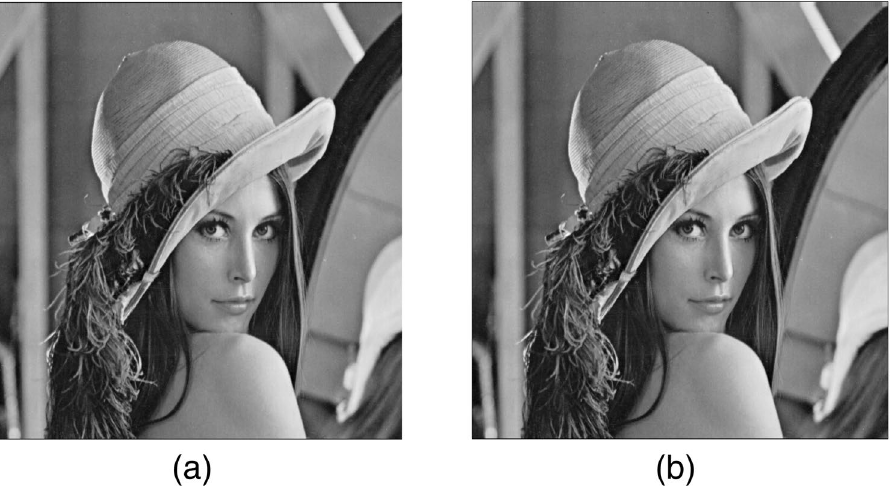
Figure 4. Images of Lena: ( a ) Original image and ( b ) Image decoded from a globally coupled system of Rulkov maps with α = 3.5, β = 0.0005, σ = 0.001 and N =